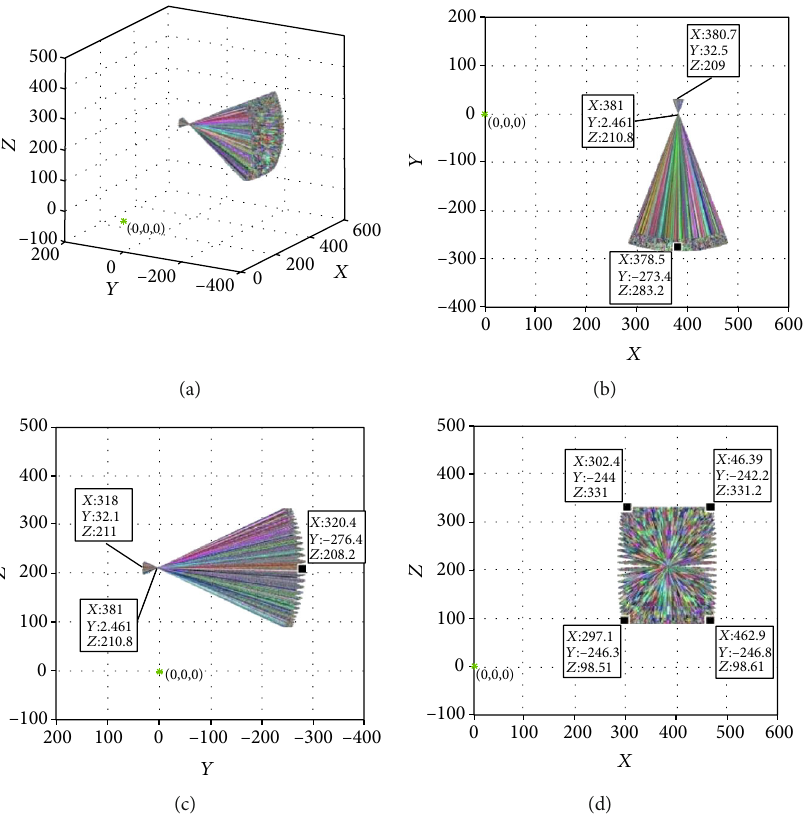
Figure 10: Posture of ultrasonic probe at 30 mm feeding: (a) three-dimensional map; (b) xoy plane projection; (c) yoz plane projection; and (d) xoz plane